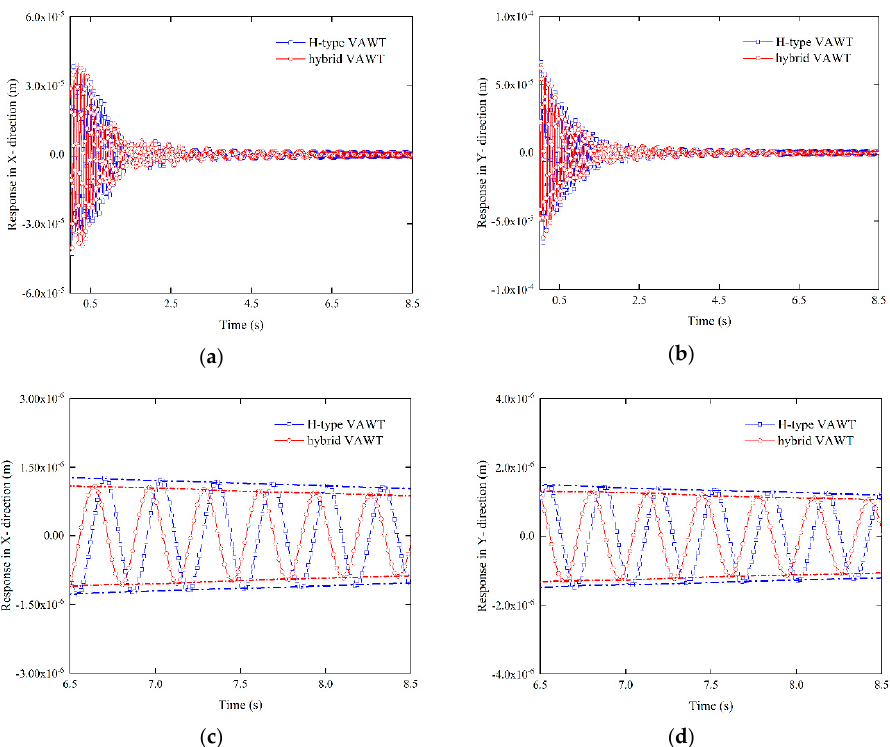
Figure 17. Forced transient responses of the 1 m ‐ mast H ‐ type and hybrid VAWTs in ( a ) X ‐ and ( b ) Y ‐ directions, and their steady ‐ state responses in the ( c ) X ‐ and (d) Y ‐ directions from 6.5 to 8.5 s. Table 14. Comparison of the maximum steady ‐ state response amplitudes of the 1 m ‐ mast H ‐ type and hybrid VAWTs in X ‐ and Y ‐ directions from their SEMs.